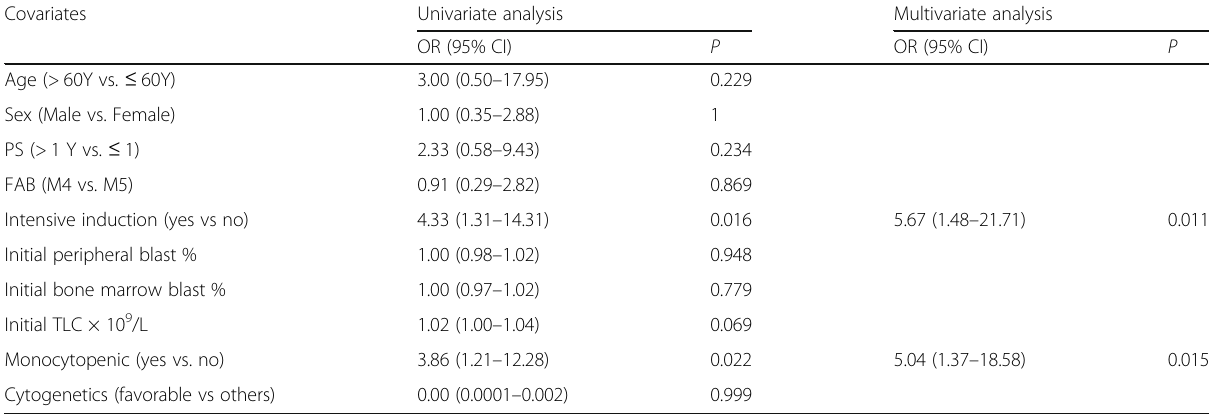
Table 3 Univariate and multivariable logistic regression analyses for response to therapy (achievement of CR) Covariates